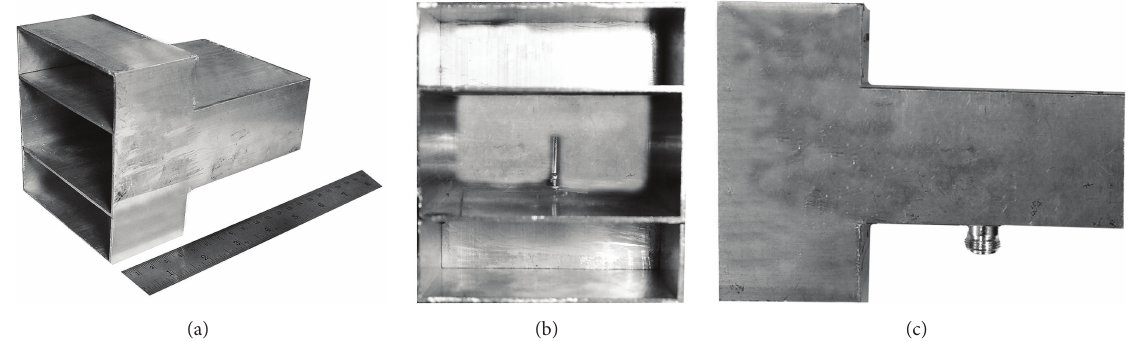
Figure 21: Photographs of the antenna prototype: (a) perspective view, (b) front view, and (c) side view.